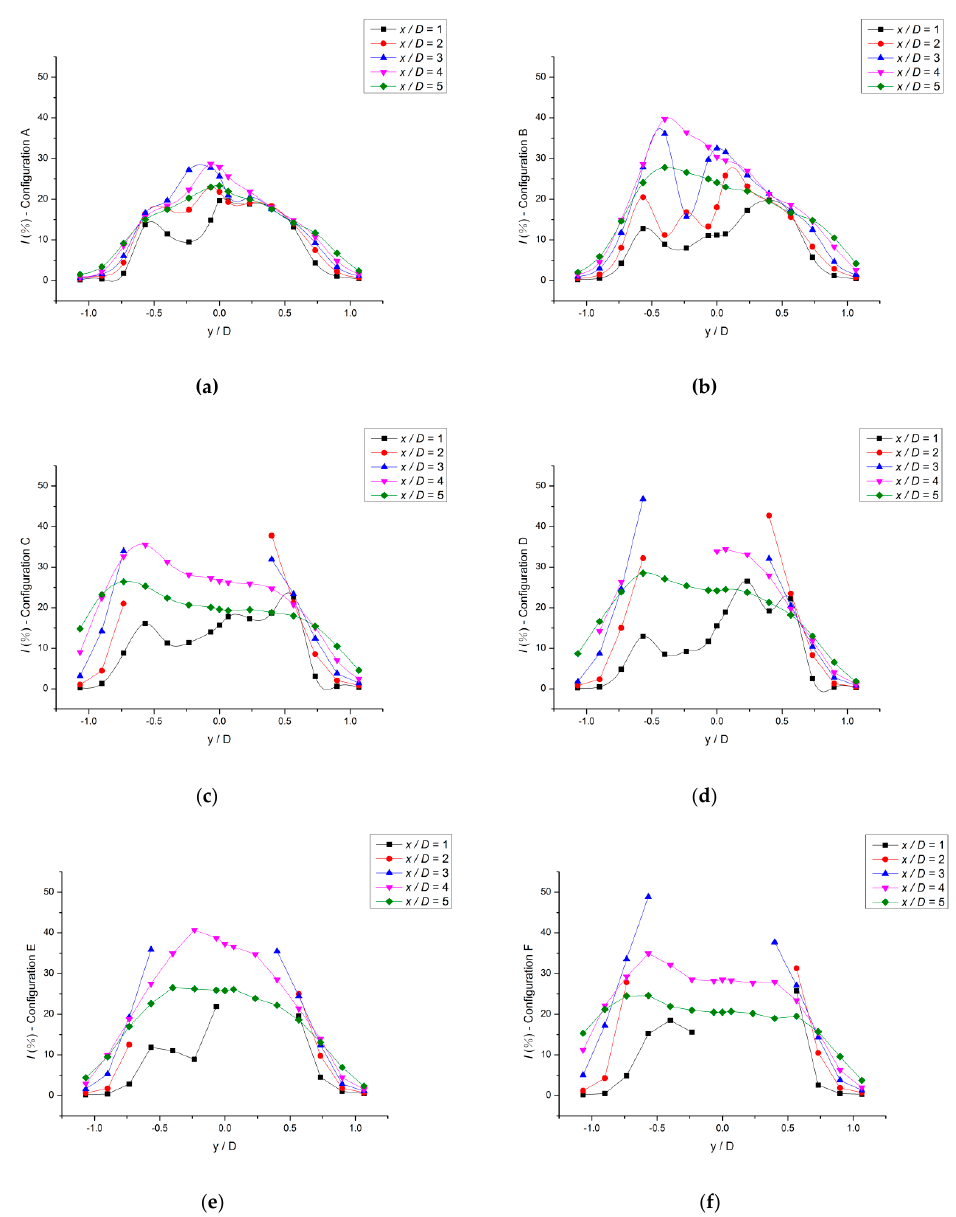
Figure 6. Turbulence intensity distribution in different configurations. Turbulence intensity distribution for ( a ) configuration A, ( b ) configuration B, ( c ) configuration C, ( d ) configuration D, ( e ) configuration e, ( f ) configuration